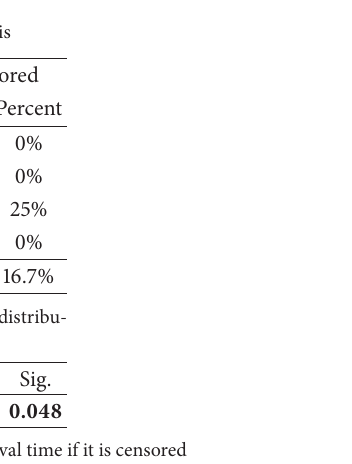
Table 5: Survival distribution stratified by primary tumor